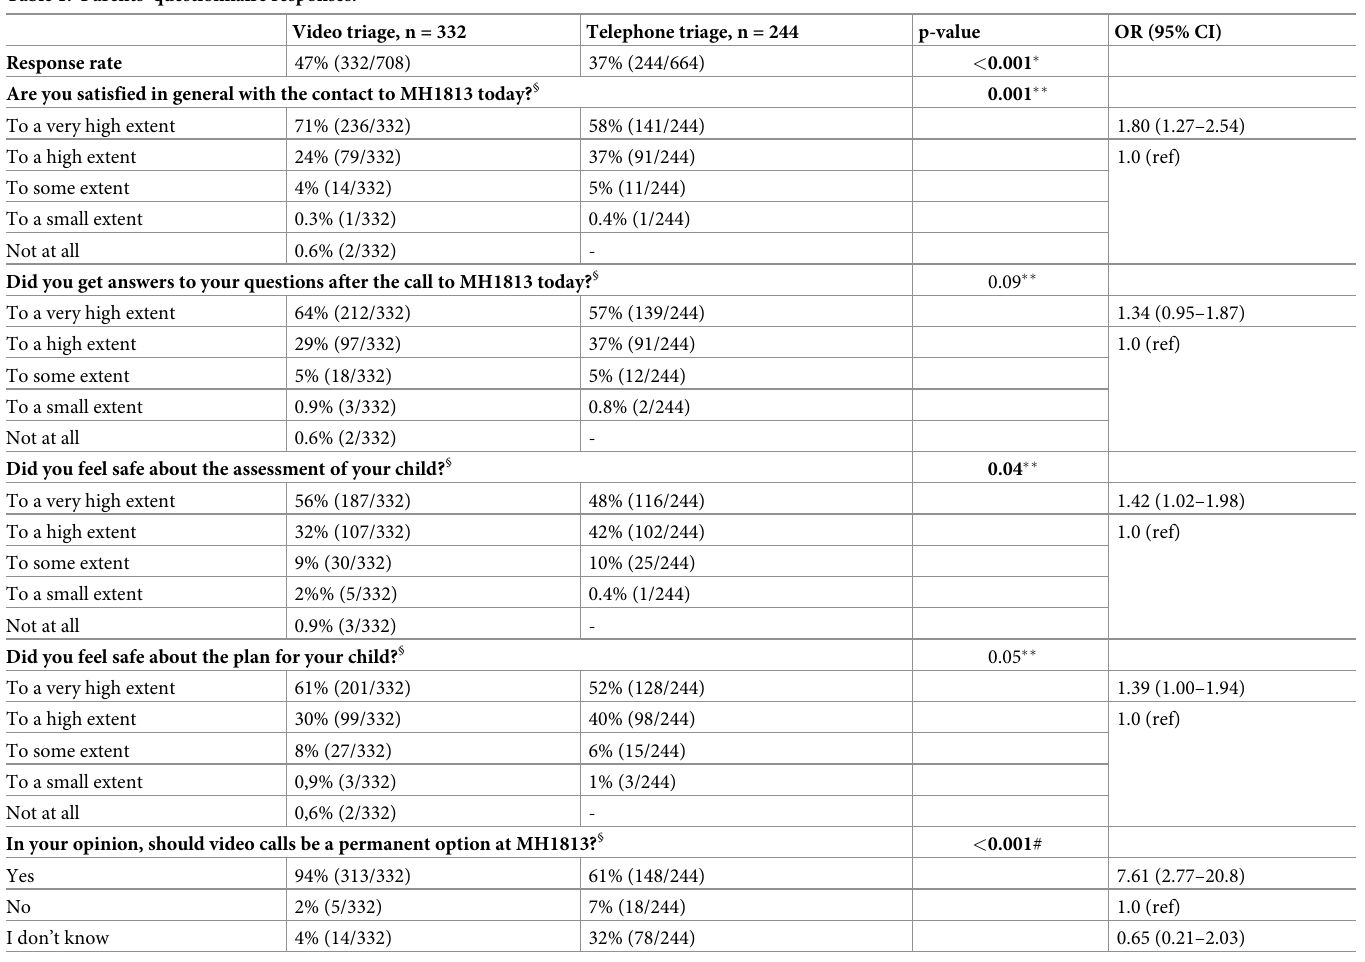
Table 1. Parents’ questionnaire